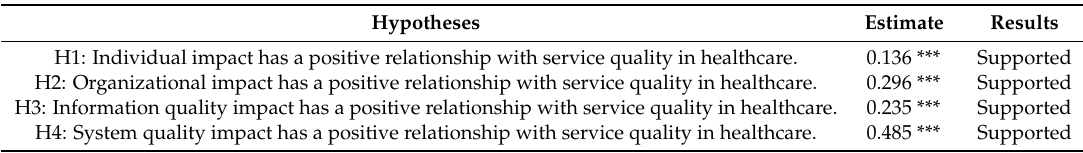
Table 4. Results of hypotheses